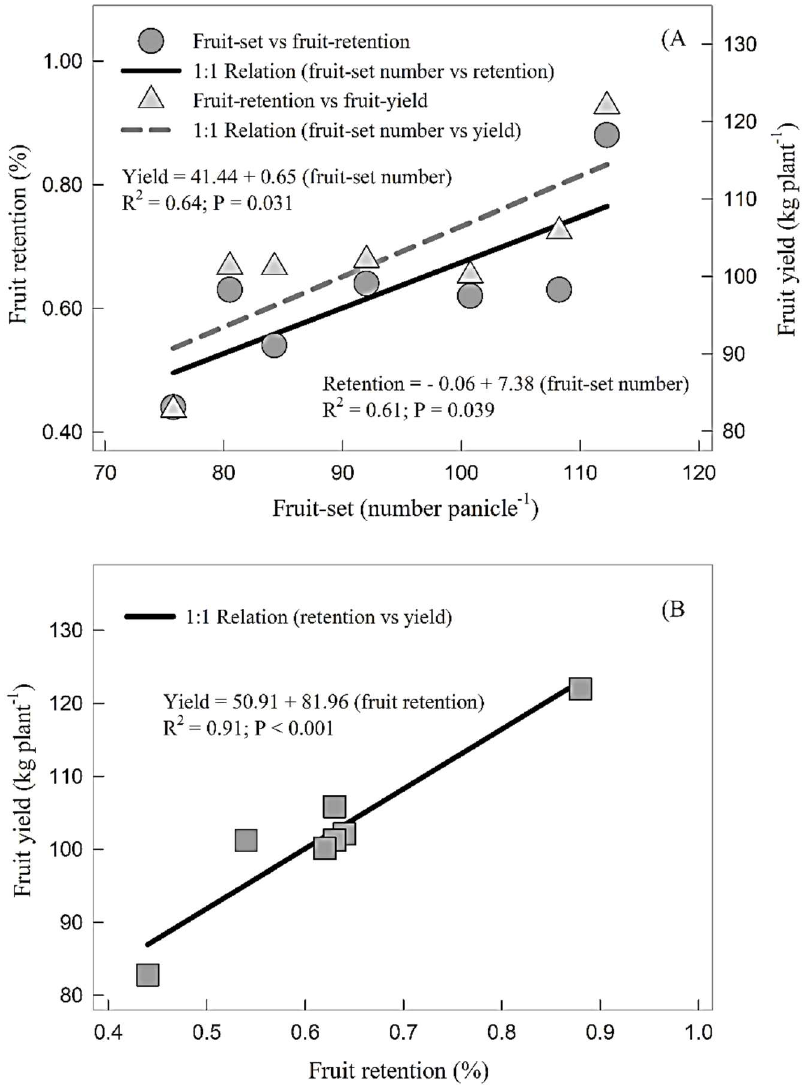
Figure 2 . ( A ) Relationship between fruit-set number per panicle and fruit retention (%), and fruit yield (kg plant −1 ). Each point shows mean ( n = 7) values. ( B ) Relationship between fruit retention percentage and fruit yield per plant. Each point shows means ( n = 7) of fruit retention percentage, and fruit yield per plant. Every correlation showed significant at p < 0.05.